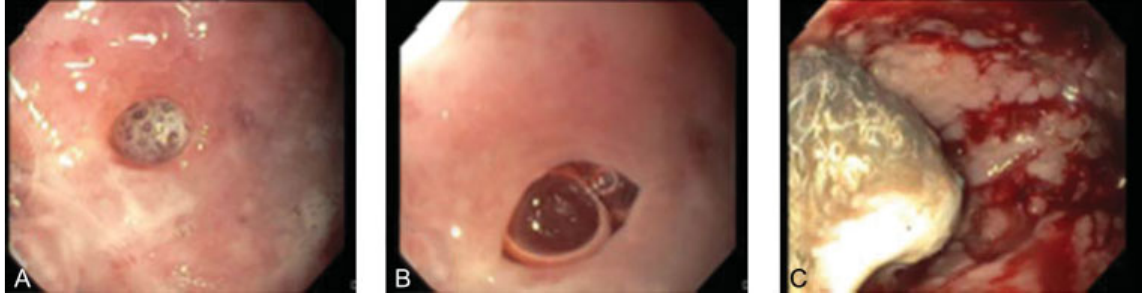
Fig. 2 Endoscopic images of gastric in fl ammation and gastrosplenic fi stula. ( A and B ) Images show pictures of two separate ulcers within there gastric wall. ( C ) Image shows generalized imm fl amation and mucosal erosions of the gastric